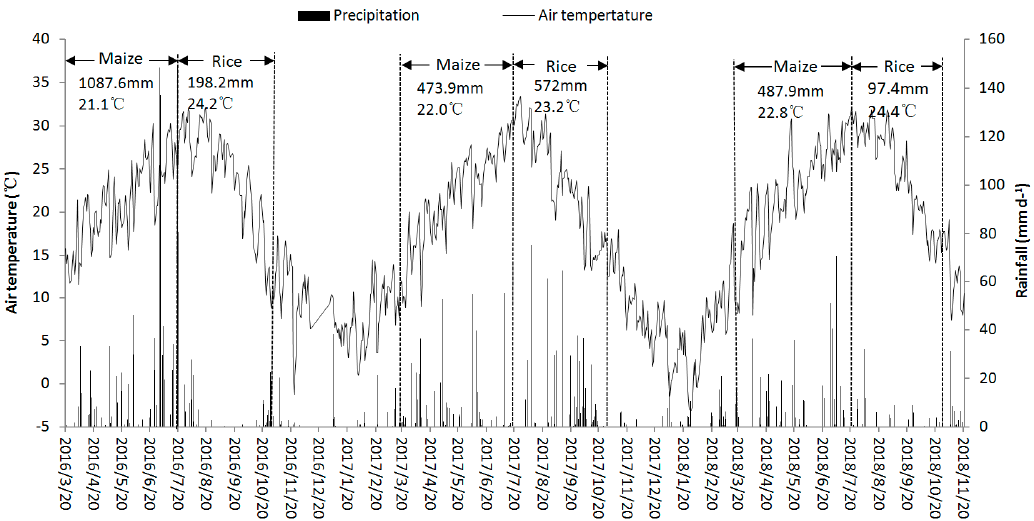
Figure 1. Mean daily air temperature ( ℃ ) and rainfall (mm) over the study period from 2016 to 2018.